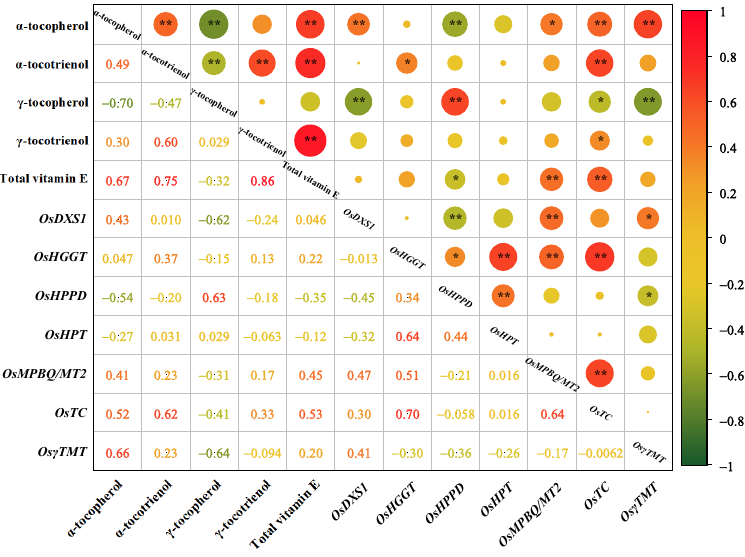
Figure 7. Correlations among vitamin E and the genes of vitamin E biosynthesis during brown rice germination. The strength of the correlation between two variables is represented by the color of the circle at the intersection of those variables. Colors range from bright orange (strong positive correlation; i.e., r 2 = 1.0) to bright green (strong negative correlation; i.e., r 2 = − 1.0).